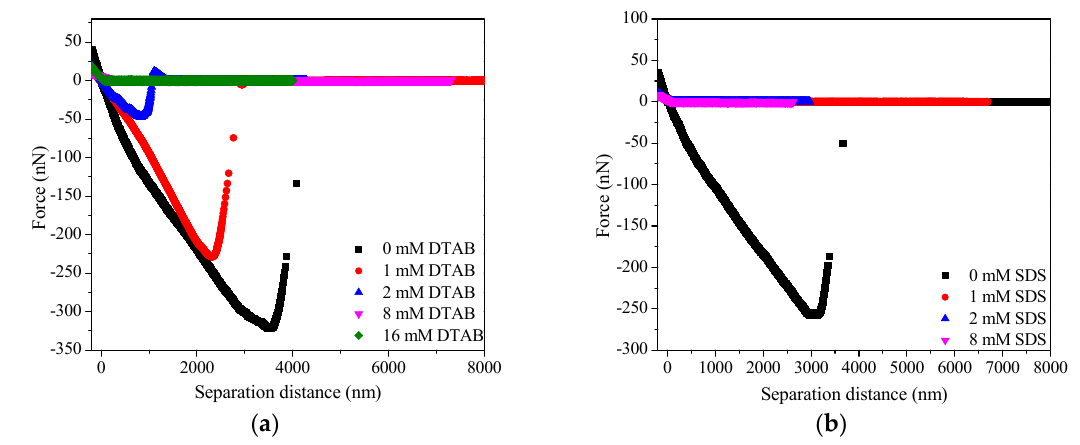
Figure 8. Effect of DTAB ( a ) and SDS ( b ) on the interaction force between hydrophobic glass microsphere (100° contact angle) and bubble.